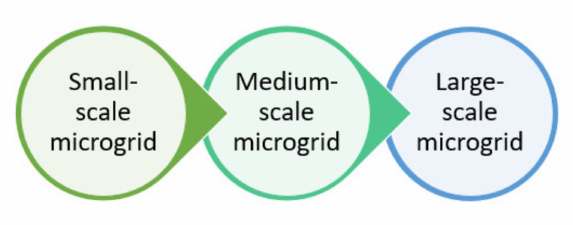
Figure 9. Classification scale of Micro-Grids.